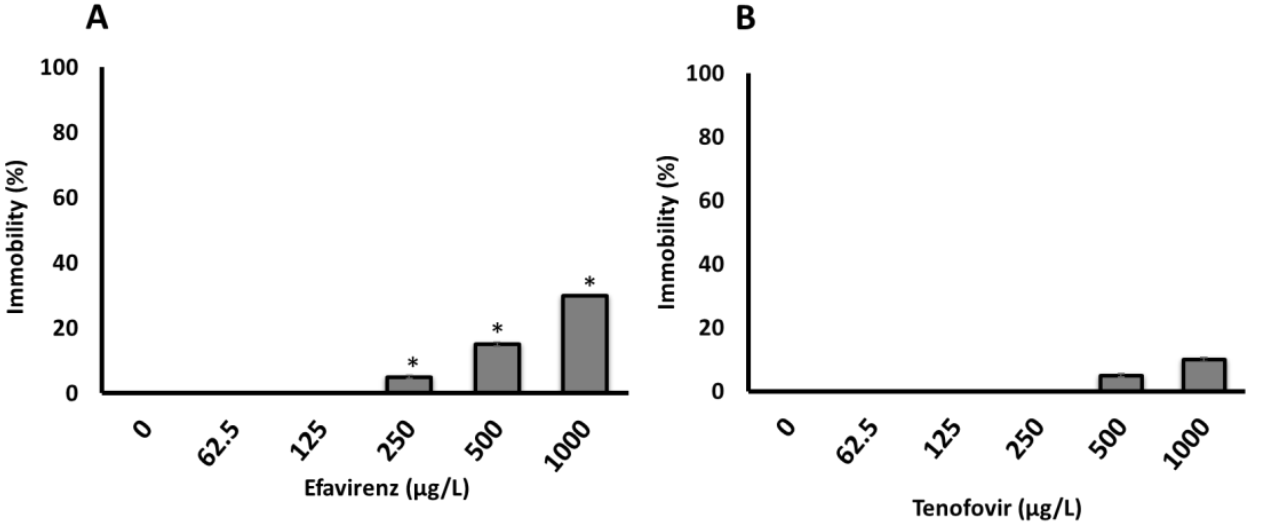
Figure 1. Immobilization of D. magna exposed to ( A ) EFV ( p -value = 0.004025) and ( B ) TFV ( p -value = 0.3313) for 48 h in ER water. Asterisks (*) represent significant difference between treatments (concentrations) from Kruskal-Wallis Test (* p <0.05). All data are the average of 4 replicates ± standard deviation.